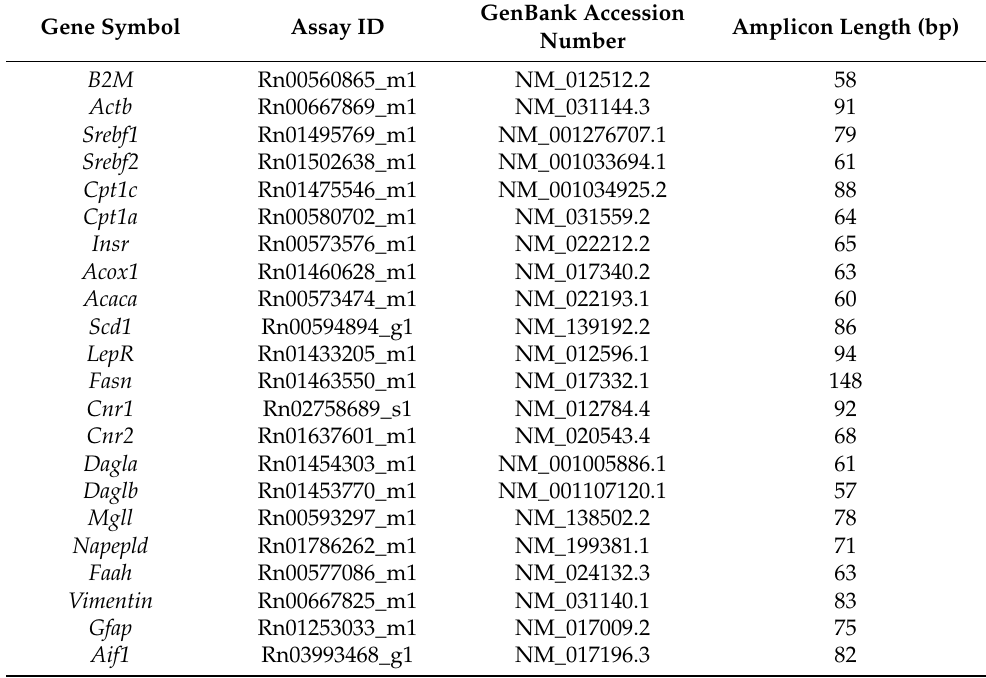
Table 1. Primer references for Taqman Gene Expression